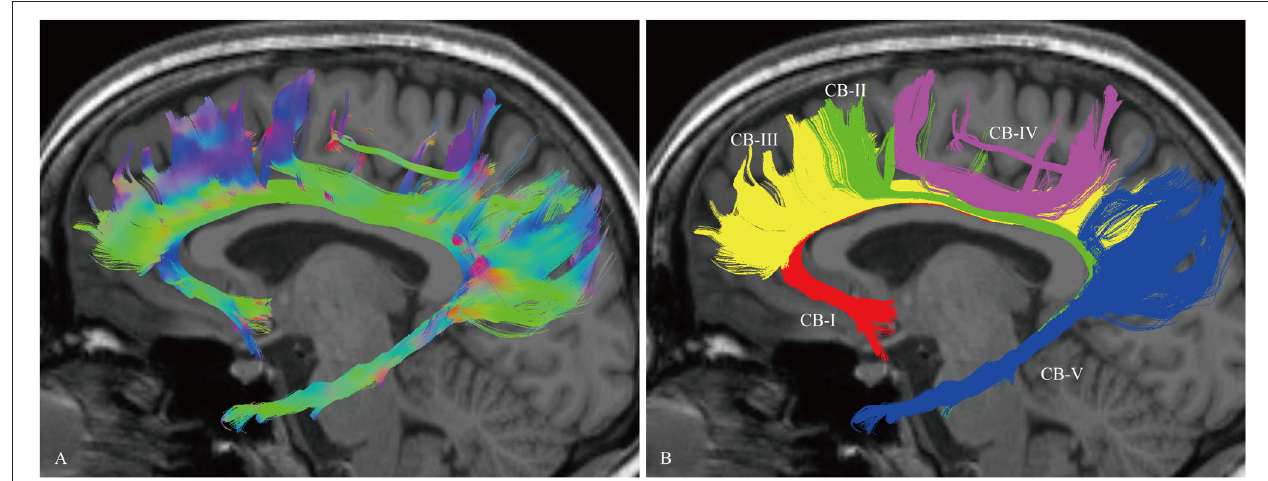
FIGURE 2 | In vivo fiber tractography of the CB and five potential subcomponents in the CB (subject-8, left). (A) Sagittal view of the left CB. The CB exhibits a sickle-shaped association bundle that nearly encircled the CC and extends to the temporal lobe. (B) Defining the subgenual areas, medial aspect of the superior frontal gyrus (SFG), precuneus, splenium and para-hippocampal gyrus as the cortex landmarks to do back-tracing for the subdivision (defined by the Automated Anatomical Labeling (Desikan et al., 2006)). Five subcomponents are identified (CB-I, red color; CB-II, green color; CB-III, yellow color; CB-IV, purple color; CB-V, blue